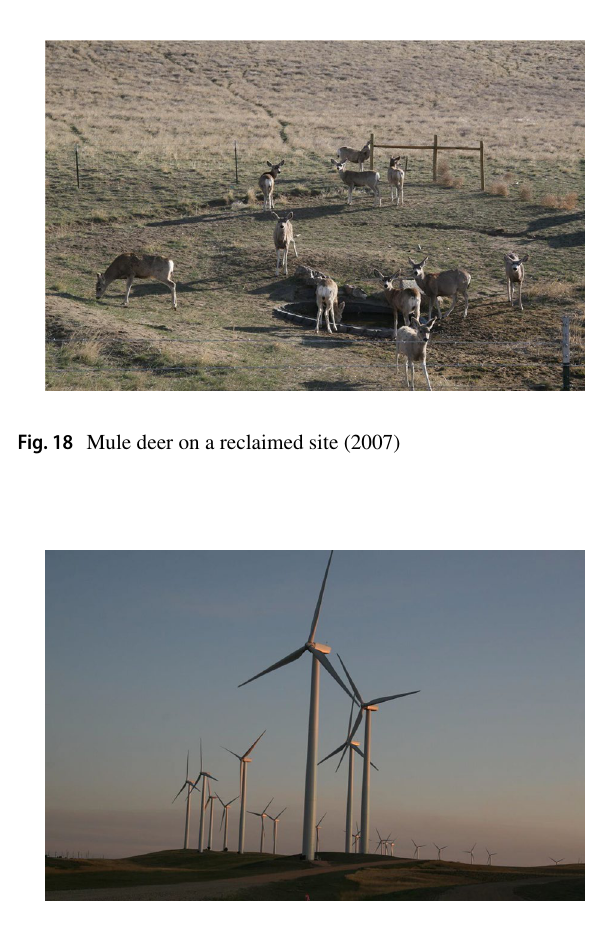
Fig. 19 Wind turbines on reclaimed